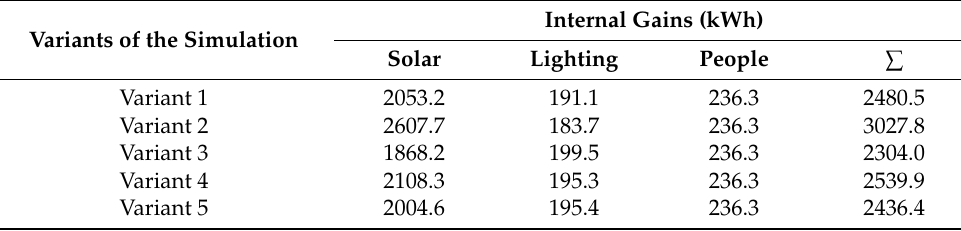
Table 4. Monthly (15.06–15.07) internal profits for the adopted variants of the simulation.